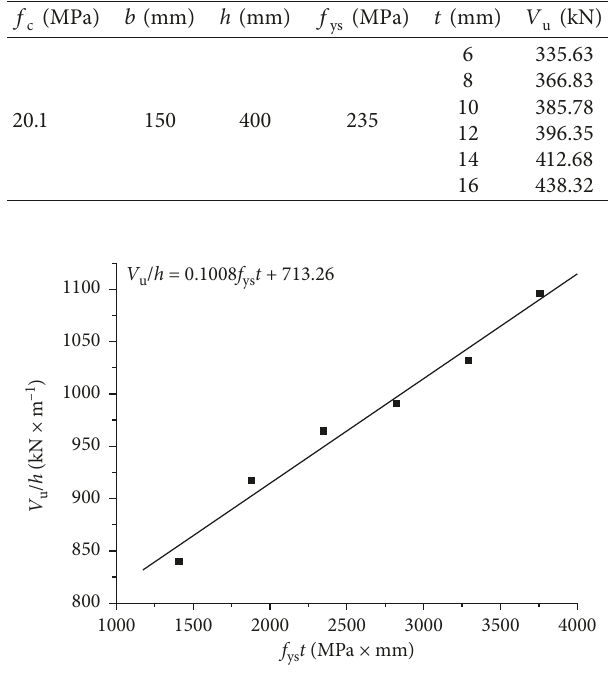
Figure 16: Fitting curve of steel plate combination coefficient.